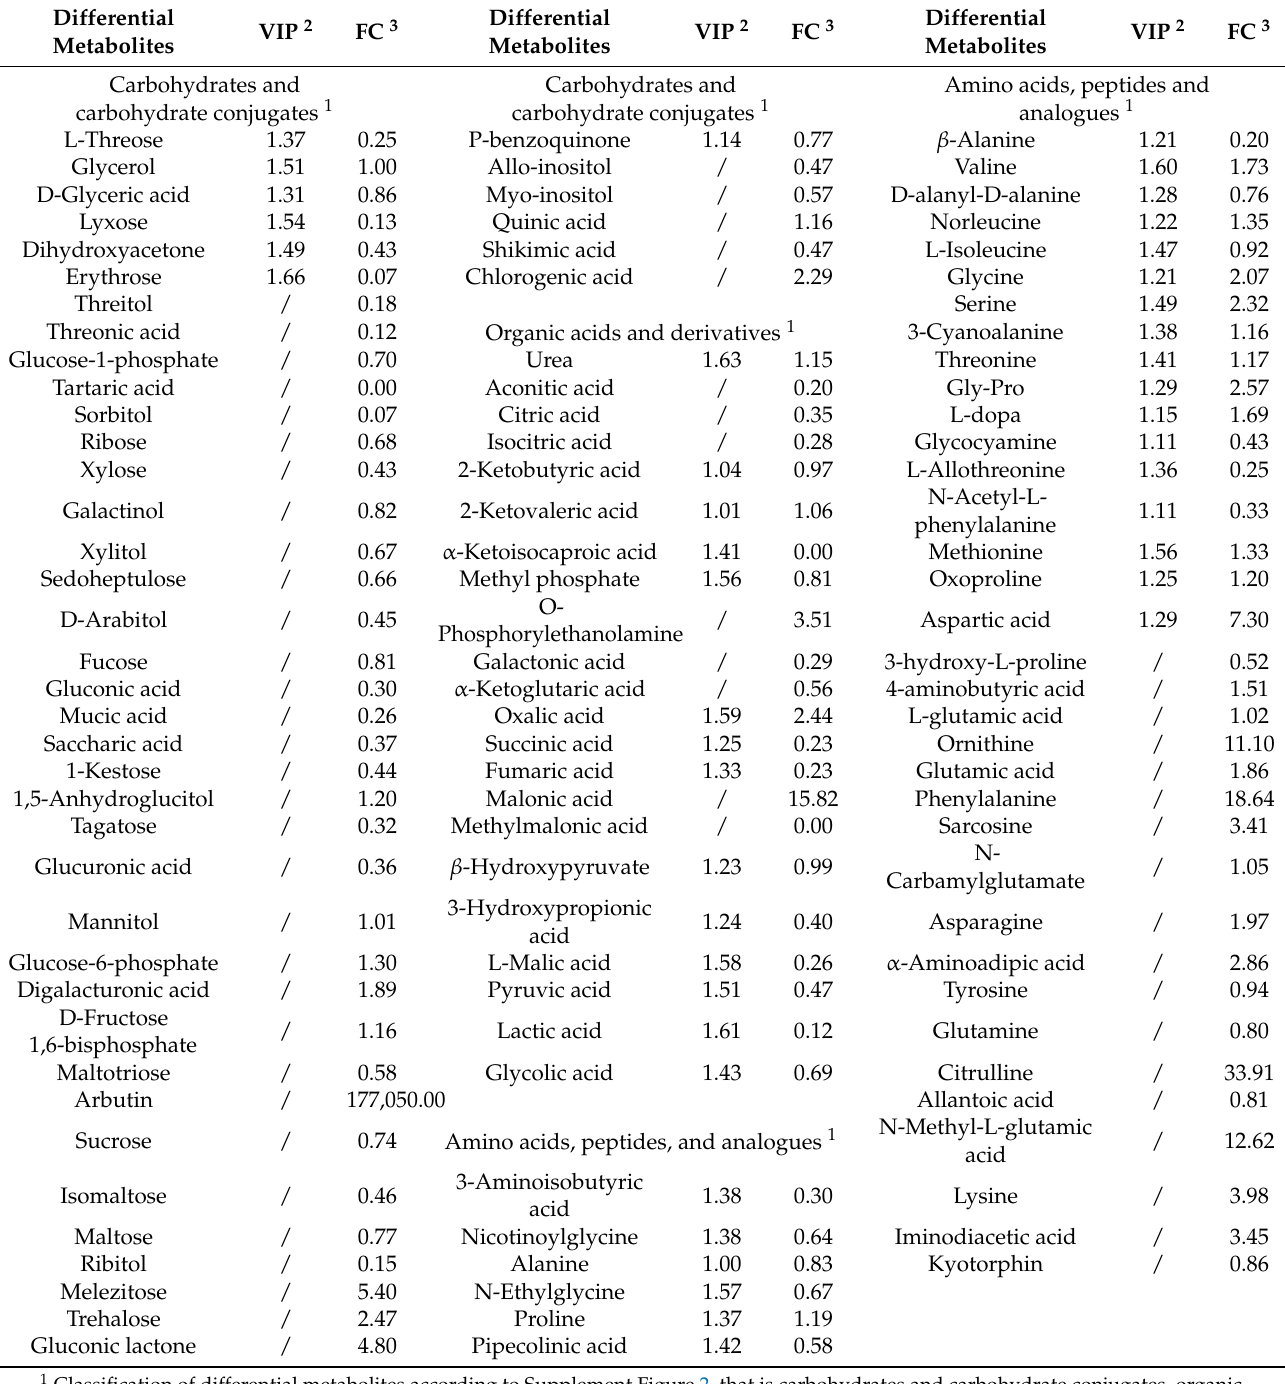
Table 2. Partial differential metabolites storage root of PSP with the fold change under